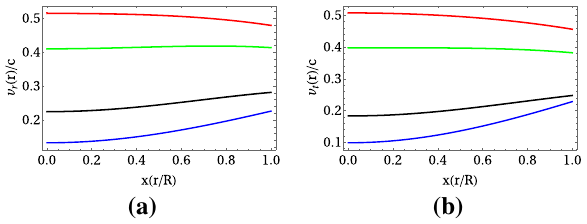
Fig. 9 Sound velocities as a function of r for compactness factor u = 0 . 19803: a radial velocity v r and b tangential velocity v t . Models 1, 2, 3 and 4 are identified with blue, black, red and green line respectively